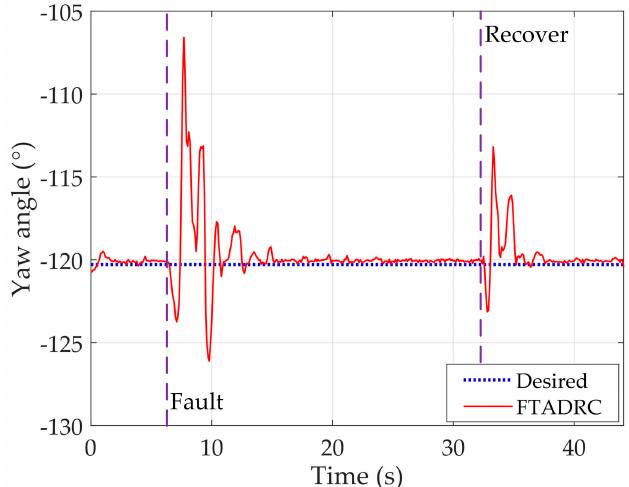
Figure 26. Curves of yaw angle.